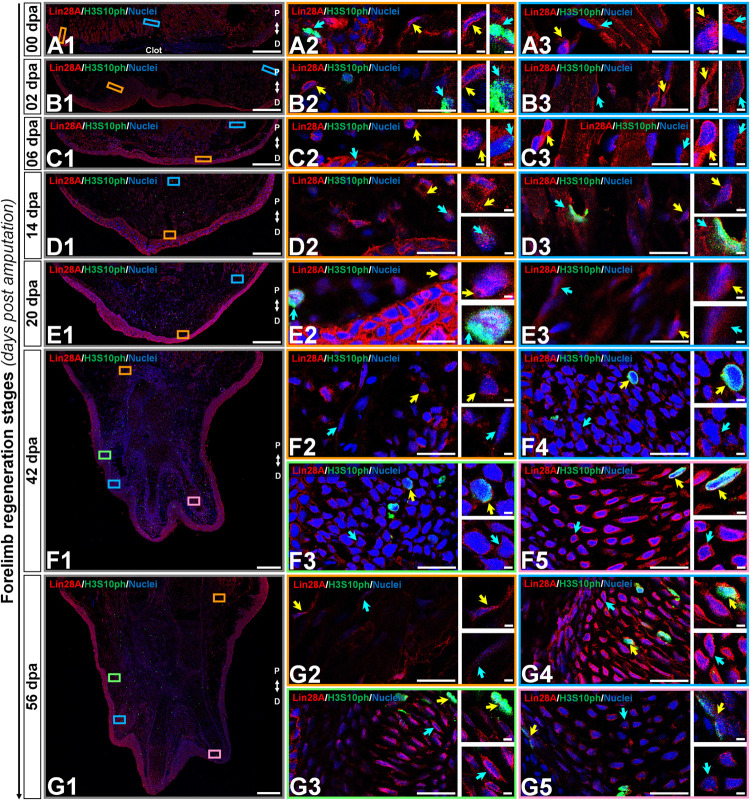
Subcellular immunolocalization of amxLin28A during forelimb regeneration. (A–G) Histological sections of key stages during limb epimorphosis arranged in the Proximal-Distal axis. (A) Uninjured limb (00 dpa). (B) Wound healing stage (02 dpa). (C) Apical epidermal cap stage (06 dpa). (D) Early blastema stage (14 dpa). (E) Medium blastema stage (20 dpa). (F) Late palette–early digits stage (42 dpa). (G) Late digits–growth stage (56 dpa). (A1–G1) Intracellular detection of amxLin28A marked in red, and H3S10ph in green for mitotic cells, by contrast with DAPI (blue) to delimit nuclei. Scale bars: 500 μm. (A2/3–G2/3/4/5) Ampliations with distinct color contours to distinguish some areas of interest for amxLin28A in red, H3S10ph in green, and DAPI in blue; yellow and cyan arrows have in turn their own magnifications. Scale bars: 50 and 5 μm, respectively. The different arrows mark diverse tissue components, as described in results.